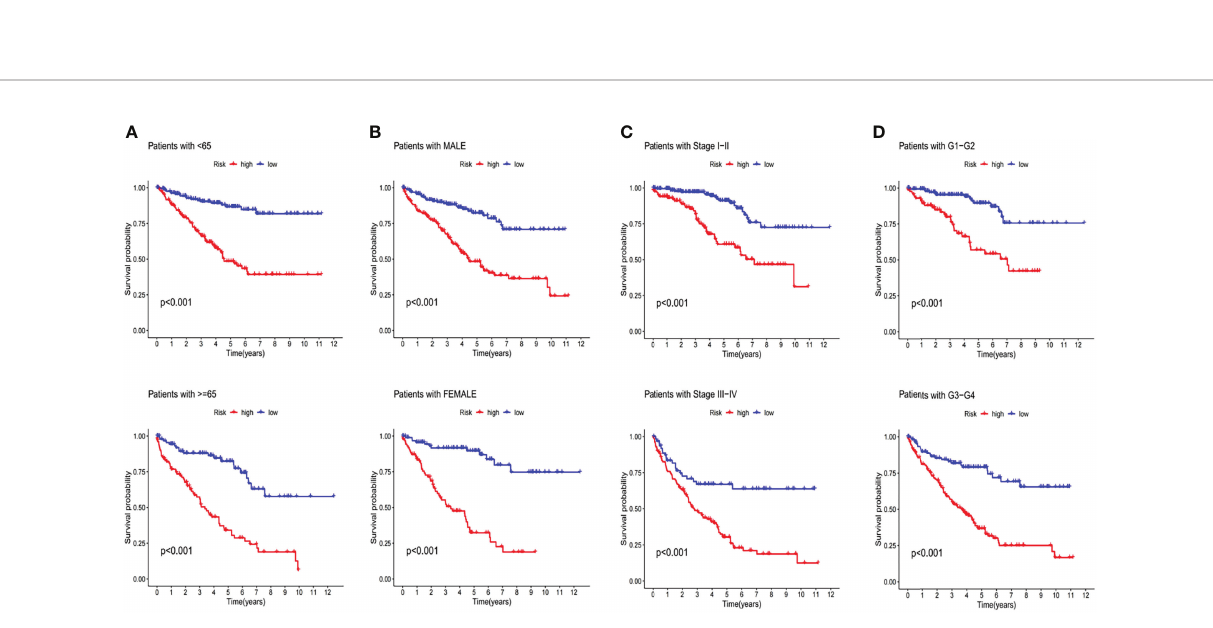
FIGURE 6 | Kaplan-Meier curves of OS differences strati fi ed by age (A) , gender (B) , stage (C) and tumor grade (D) between both groups in the entire TCGA